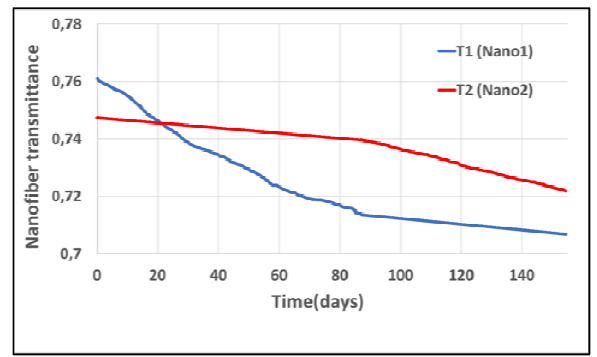
Fig. 2. Typical transmittance